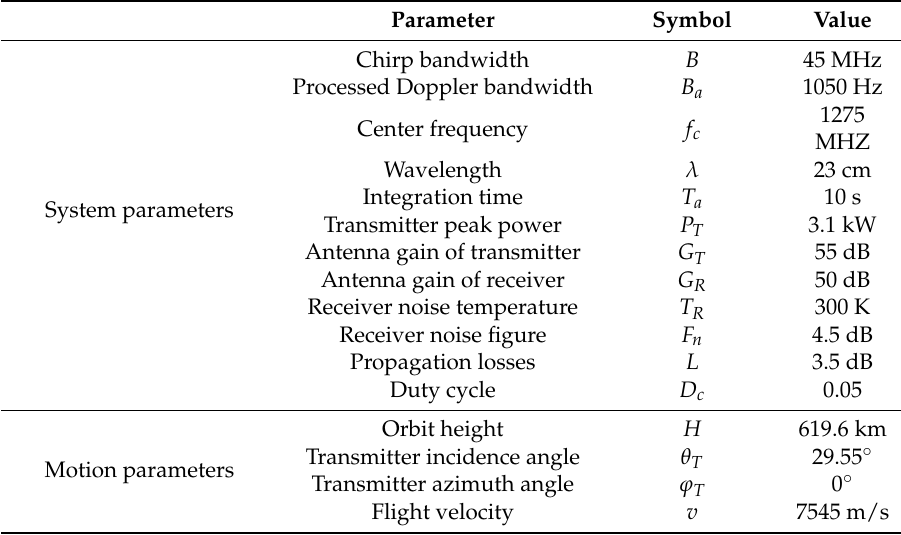
Table 1. Key simulation parameters.